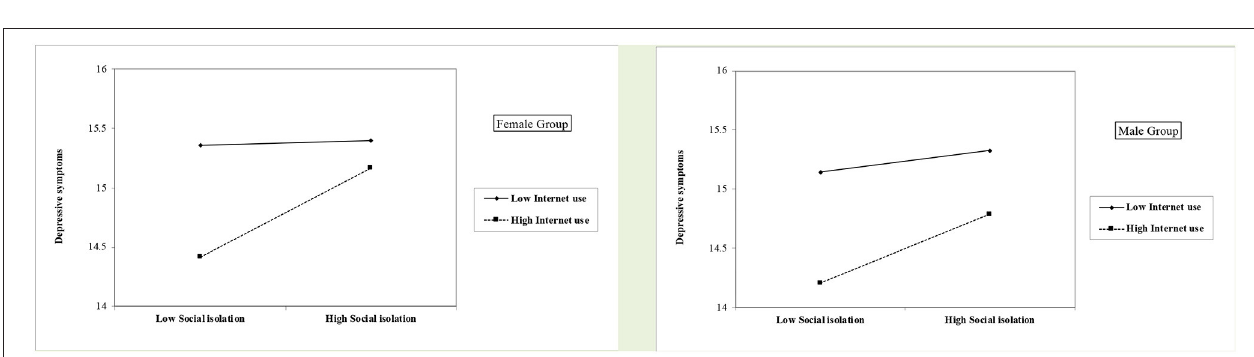
FIGURE 4 | Role of social isolation on cognitive function by levels of internet use among the female and male group.